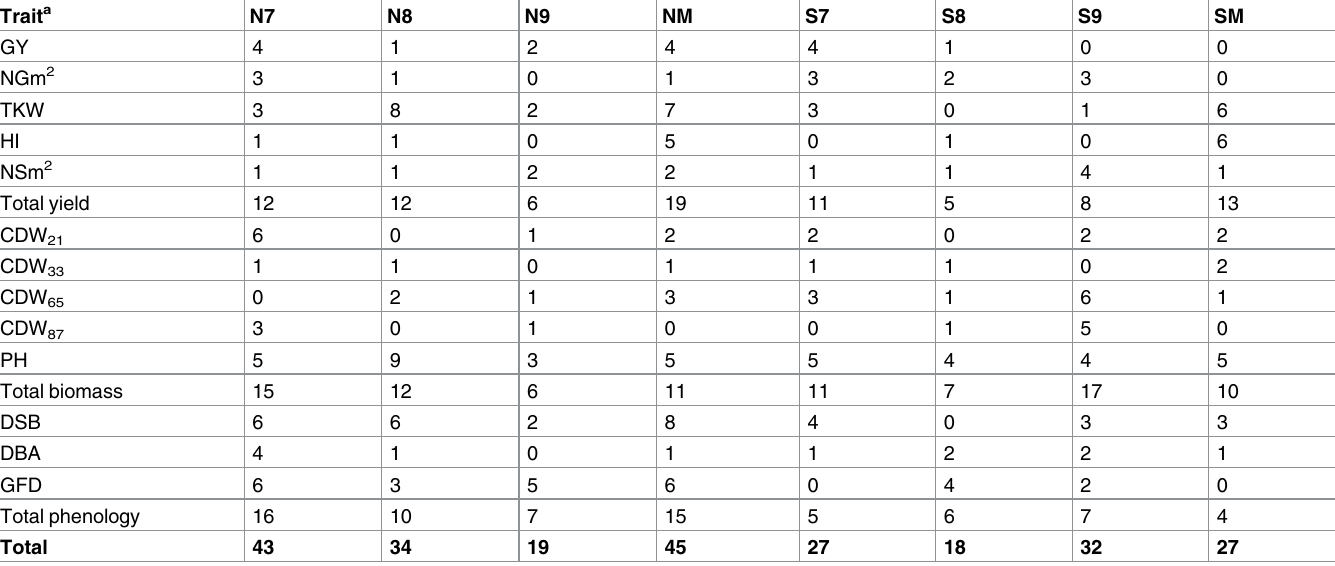
Table 1. Number of significant associated markers. Trait